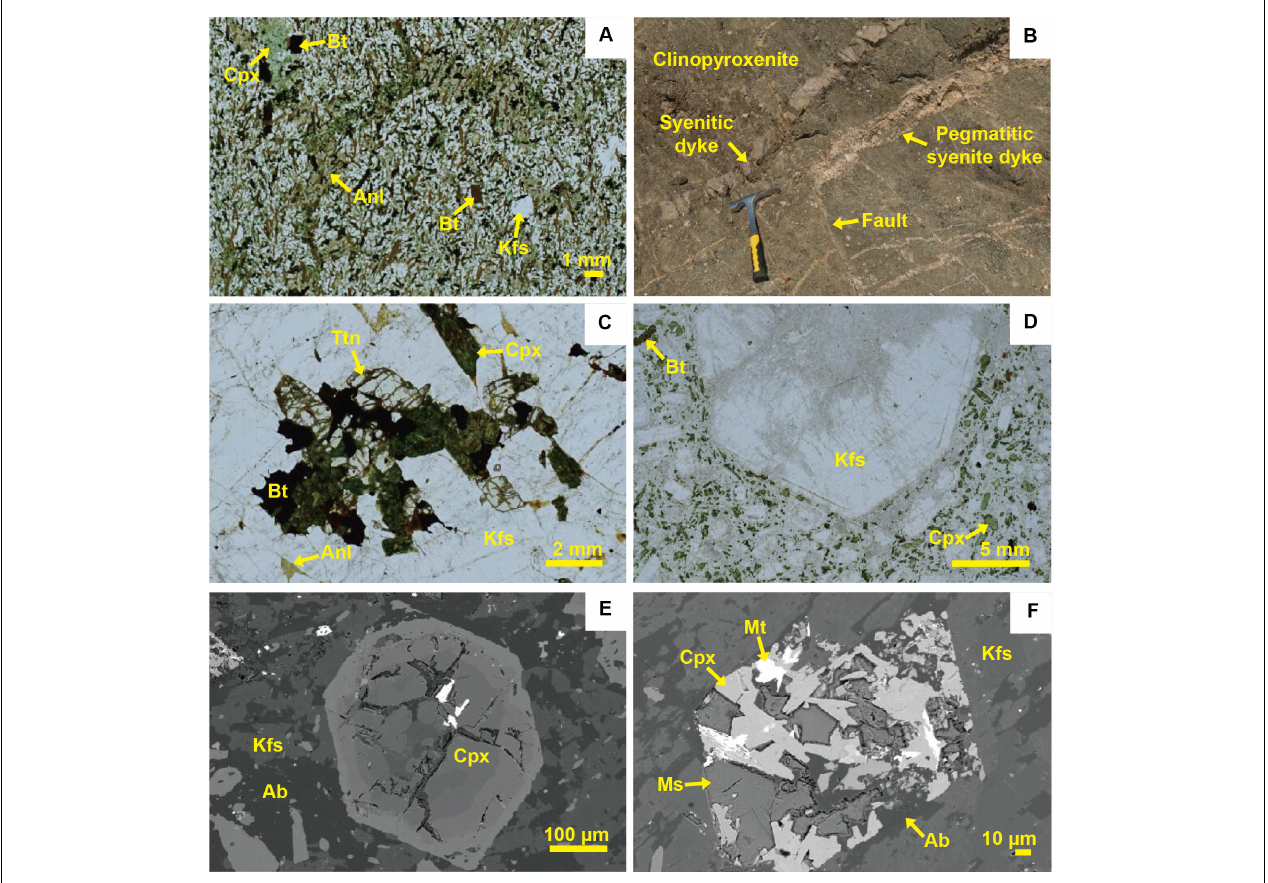
FIGURE 7 | Petrographic photos of dykes. (A) Clinopyroxenite dyke showing the analcite network (scanned photo of thin section). (B) Field photo showing the relationship between syenitic dykes and faults. (C) Coarse euhedral titanite in late-stage syenitic dyke (scanned photo of thin section). (D) Pegmatitic K-feldspar crystal in late-stage syenitic dyke (scanned photo of thin-section). (E) Euhedral zoned clinopyroxene with aegirine rim, also showing the albite exsolution in the matrix (BSE image). (F) Clinopyroxene replaced by muscovite, magnetite and albite (BSE image). Abbreviations are as